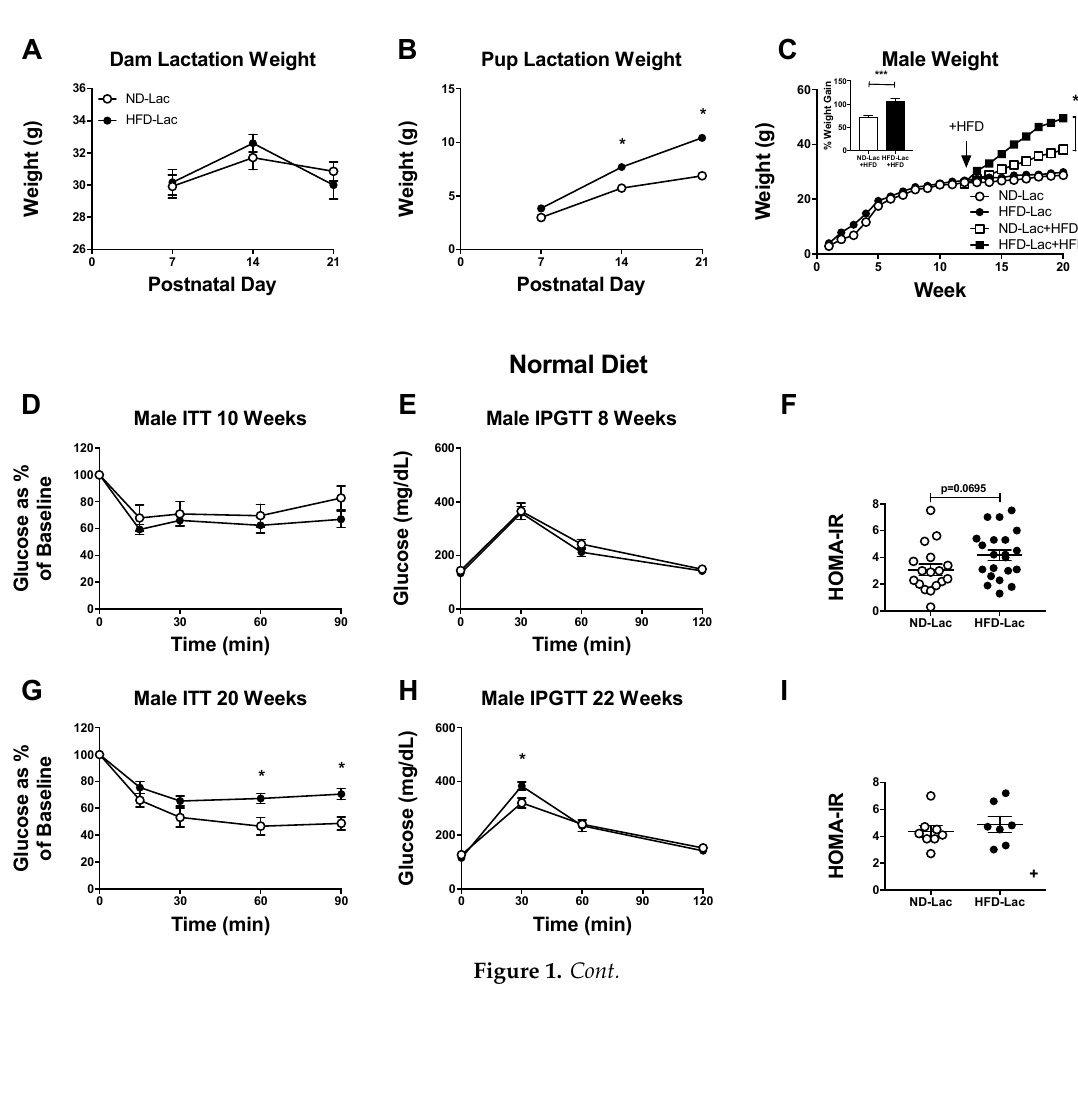
Figure 1. Male lactation high-fat diet (HFD) offspring show insulin resistance and mild glucose intolerance on a normal diet. Analyzed experimental groups: ND-Lac (white circles), HFD-Lac (black circles), ND-Lac + HFD (white squares), HFD-Lac + HFD (black squares). Weekly weights of dams during the lactation period starting on postnatal day 7 ( A ). Weekly weights of male and female offspring during the lactation period ( B ). Weekly weights of male offspring throughout adulthood, arrow indicates the start of HFD re-challenge ( C ). Data collected from males maintained on a normal diet ( D – I ). Insulin tolerance tests (ITT) at 10 weeks of age, 6 h fast, 0.75 U/kg insulin, ND-Lac n = 7, HFD-Lac n = 10 ( D ). Intraperitoneal glucose tolerance tests (IPGTT) at eight weeks of age, 6 h fast, 2 g/kg dextrose, ND-Lac n = 8, HFD-Lac n = 13 ( E ). HOMA-IR at eight weeks of age measured after 6 h fast ( F ). ITT at 20 weeks of age, ND-Lac n = 5, HFD-Lac n = 12 ( G ). IPGTT at 22 weeks of age, ND-Lac n = 4, HFD-Lac n = 7 ( H ). HOMA-IR at 23 weeks of age ( I ). Data collected from males re-challenged with HFD at 12 weeks of age (+HFD) ( J – L ). ITT after eight weeks of HFD feeding, 1 U/kg, ND- Lac+HFD n = 10, HFD-Lac+HFD n = 11 ( J ). IPGTT after 10 weeks of HFD feeding, 0.66 g/kg dextrose,